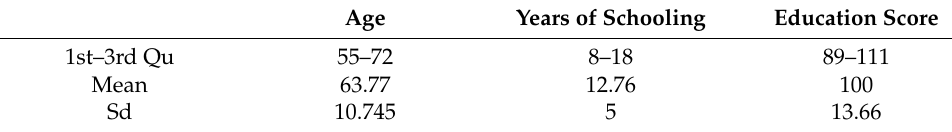
Table 5. Descriptive table for Age, years of schooling, and Education